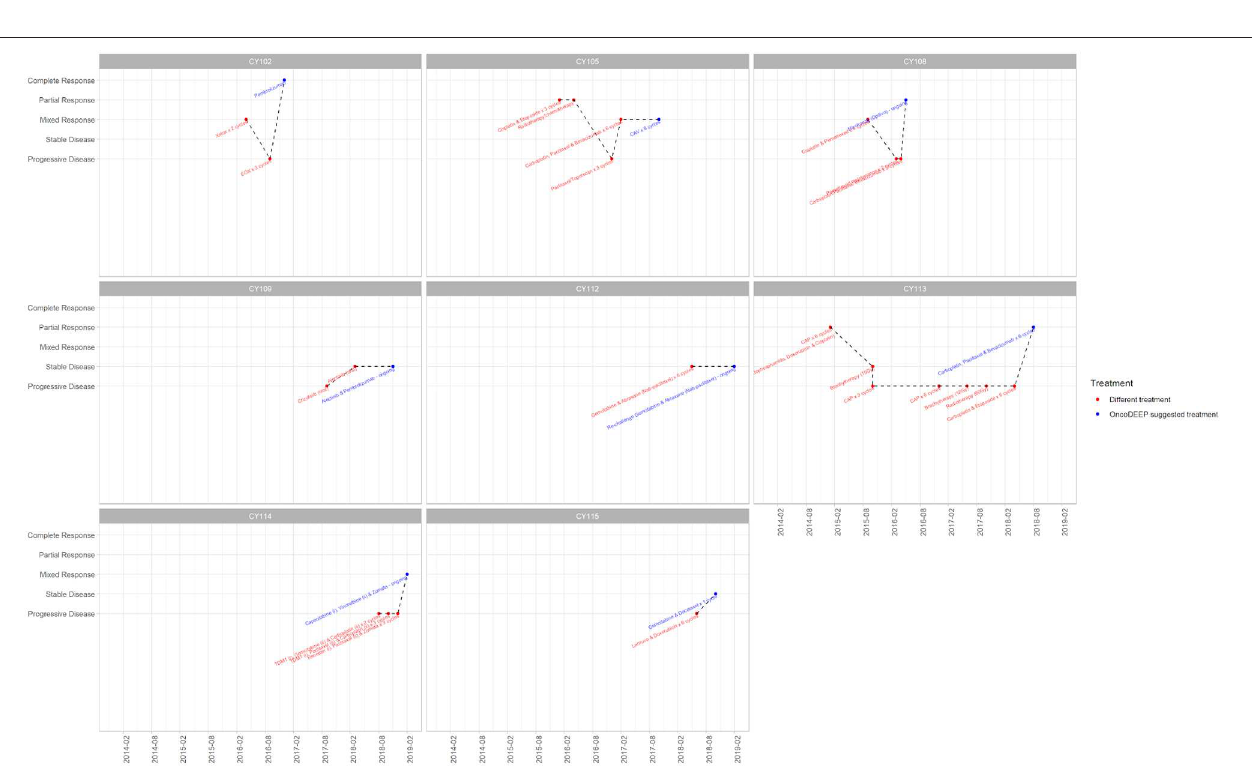
FIGURE 1 | Treatment record for the eight patients that showed positive response to the suggested treatment. The x -axis displays a timeline (per 6 months), while the y -axis shows the response of the patient before applying the displayed treatment. Therapy regimens given before the personalized assessment are shown in red, whereas the personalized treatment is highlighted with blue. Plots were created using the ggplot2.